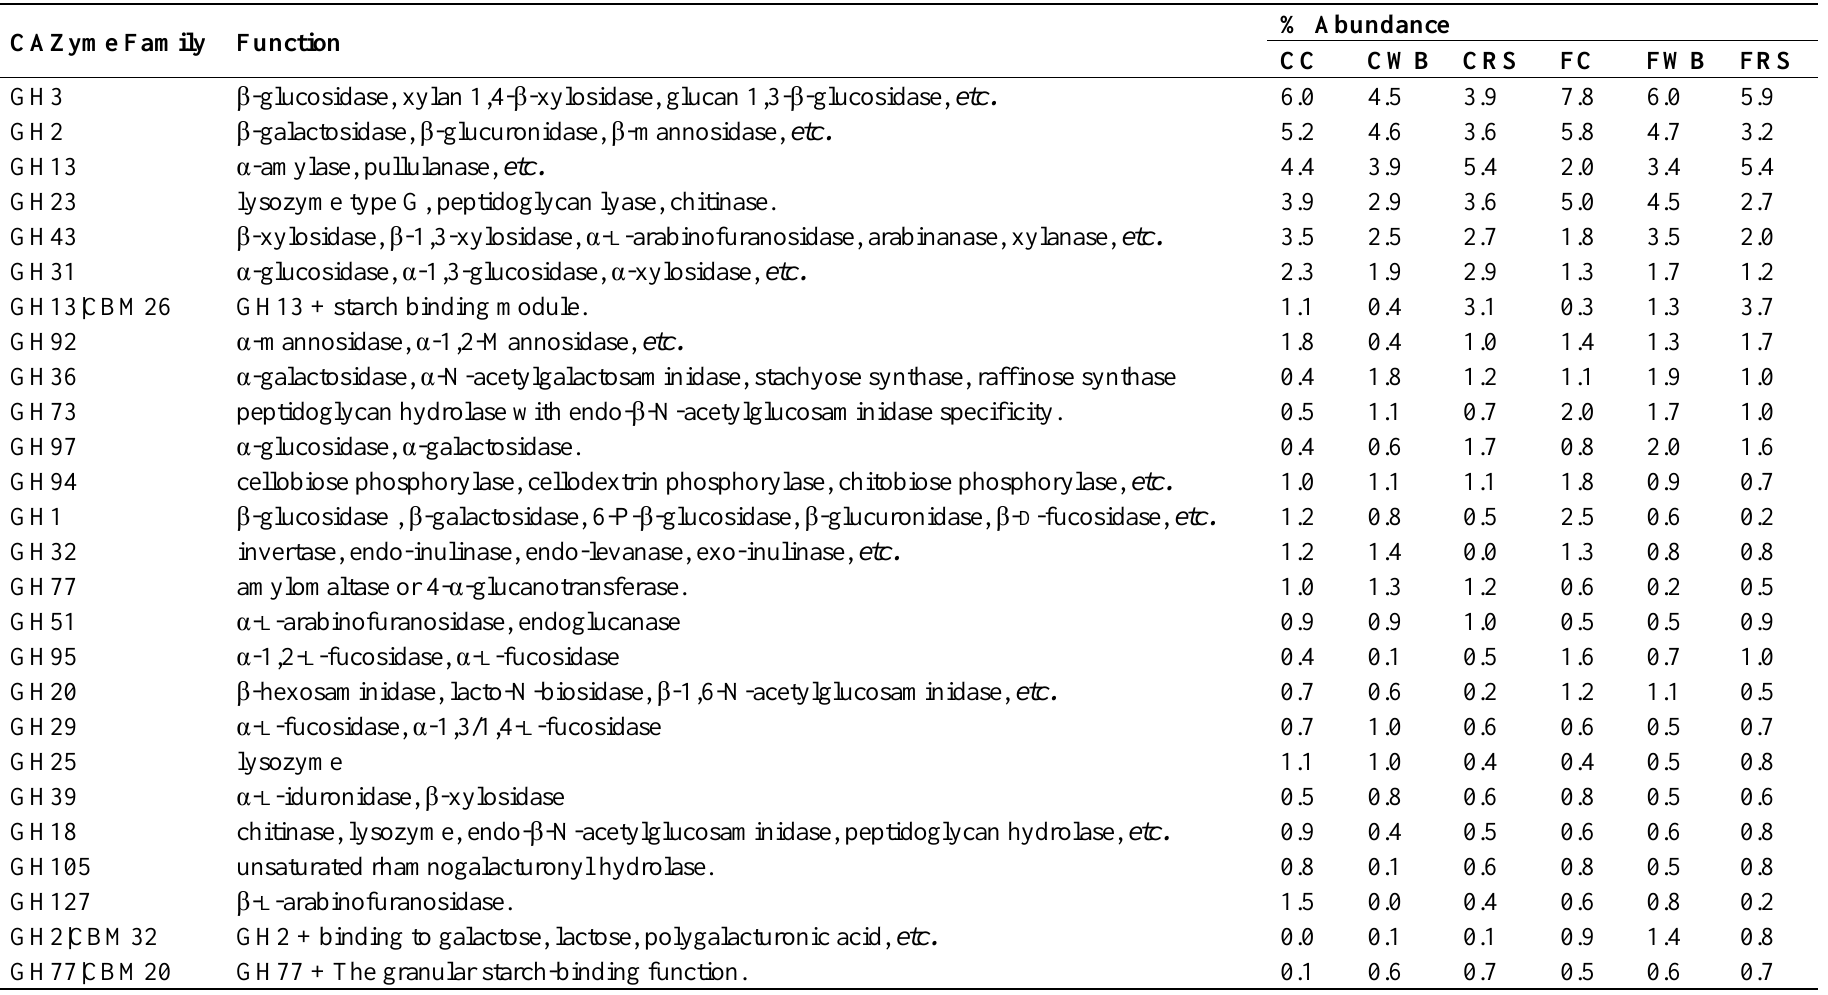
Table 4. Abundant glycosyl hydrolase families (>1% of total abundance in at least one community) identified in the cecal and fecal communities of rats fed each diet. CC: cecal cellulose. FC: fecal cellulose. CWB: cecal wheat bran. FWB: fecal wheat bran. CRS: cecal resistant starch. FRS: fecal resistant